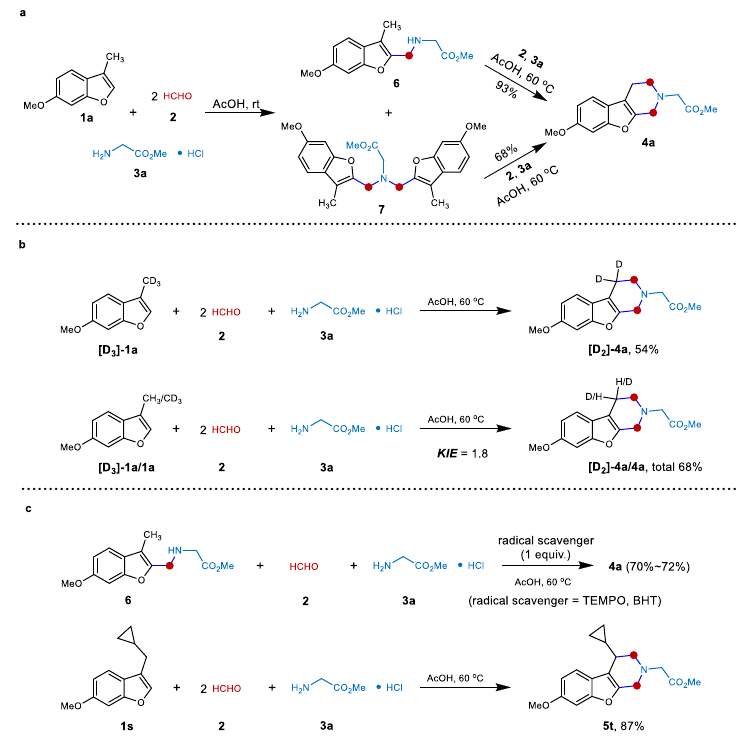
Fig. 5 Mechanistic studies. a Control reaction. b Kinetic isotope effect experiments. c Radical-probe